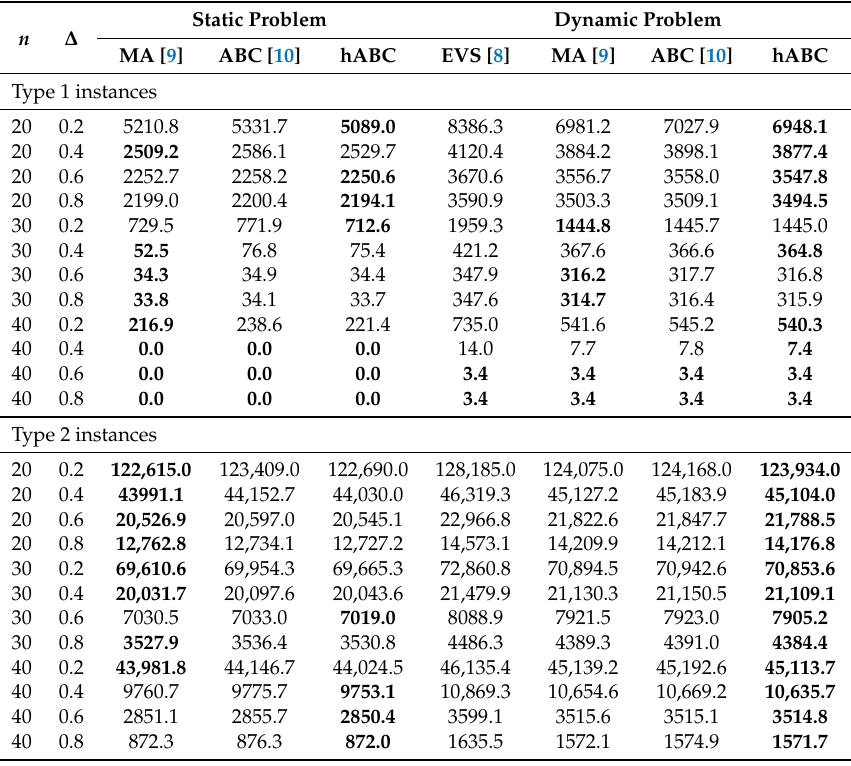
Table 2. Comparison of hABC to the state-of-the-art methods on the instances of scenario1. The best values obtained for each set of instances are remarked in